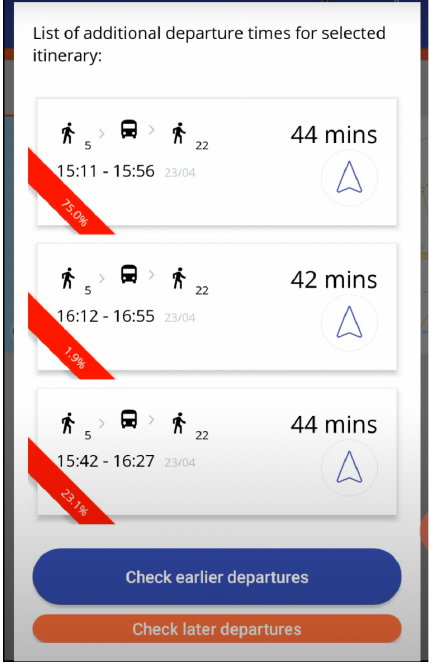
Figure 5. My-Trac suggests optimal means of transport for the destination.